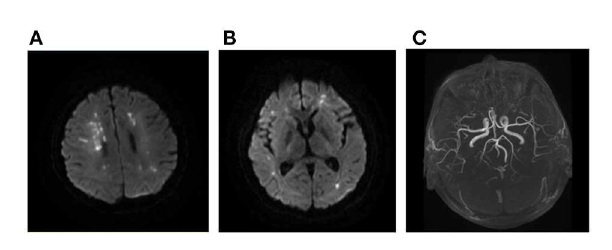
FIGURE3 Ischemic lesions related to hypercoagulability. A 22-year-old man with SLE and APS presented with weakness of left upper and lower limbs. Multiple sporadic infarcts were located only at supra-tentorial regions involving bilateral hemispheres (A, B) . No large vessel stenosis was found in the MRA (C) . SLE, systemic lupus erythematosus; APS, antiphospholipid syndrome; MRA, magnetic resonance angiograph.